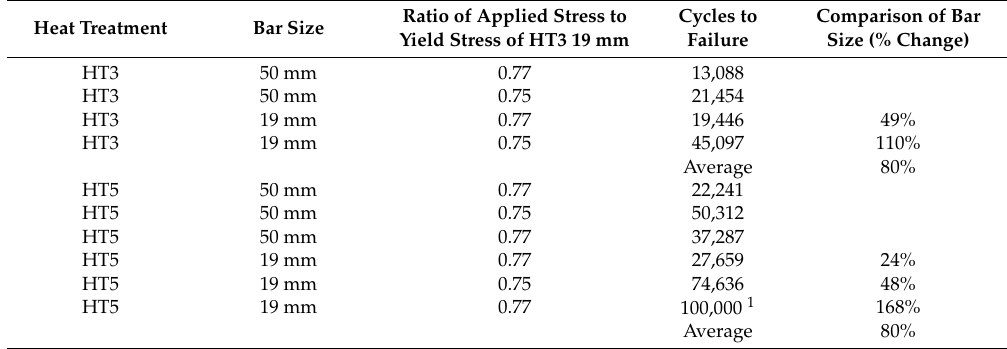
Table 5. The results of load control fatigue tests of the different conditions tested at room temperature and different